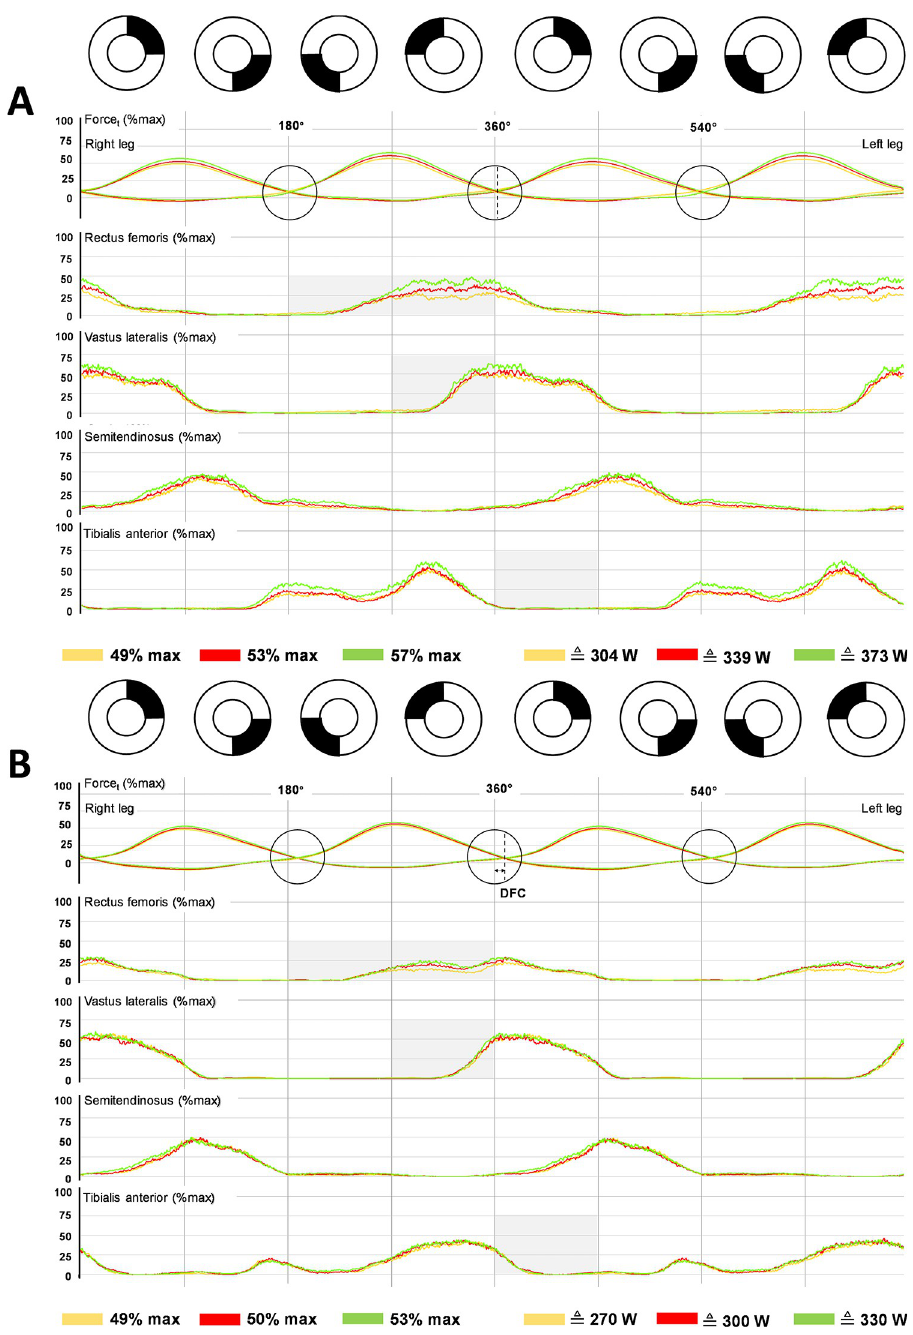
Fig 2. Group comparisons of recruitment patterns of lower limbs muscles at the MLSSw in CP-test. (A, B) Averaged bi-pedal crank force and EMG data across two pedal cycles (0–720˚) at MLSSw–10% (yellow), MLSSw (red) and MLSSw + 10% (green) for group A (A) and group B (B) (both n = 7). Group comparisons reveal differences in force development, negative force level and recruitment patterns for RF, VL and TA (see gray shaded areas). Note also the vertical crossing points of the tangential force (Ft) and the delay at the TDC (Delay Ft crossing = DFC) at 180˚/ 360˚/540˚ in marked circles.